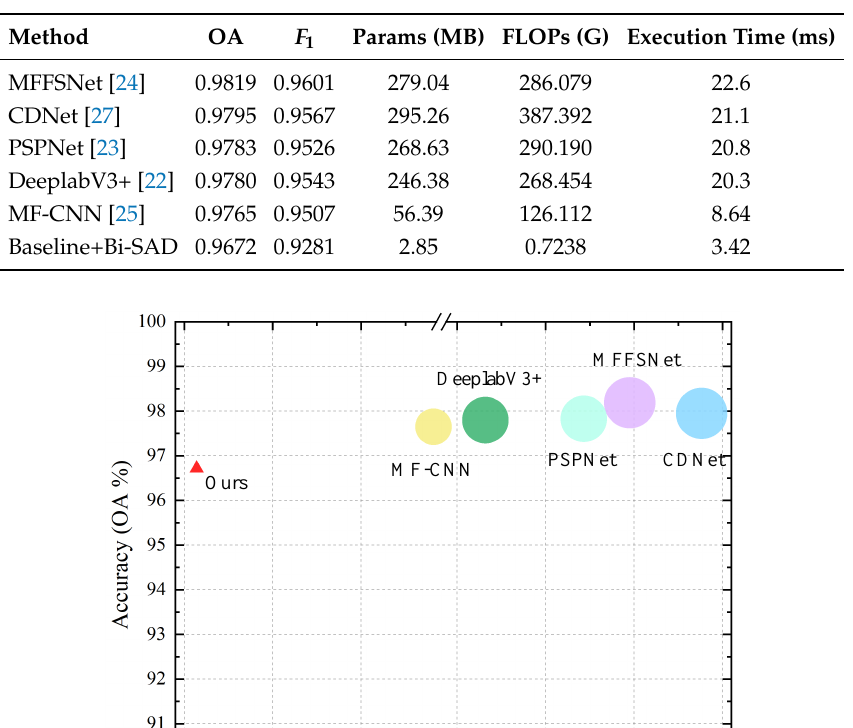
Table 4. The comparison of state-of-the-art cloud detection methods with ours.